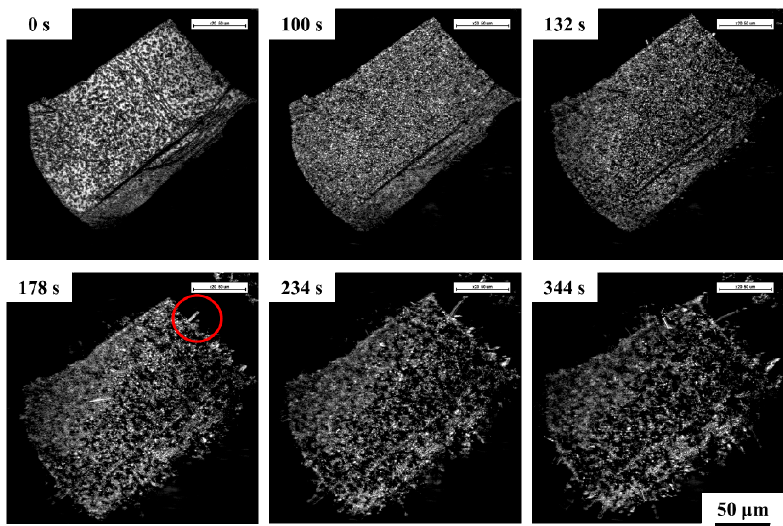
Figure 6. The growth of iron whiskers during in-situ online observation experiment: 1073 K with 75% CO + 25% CO 2 .